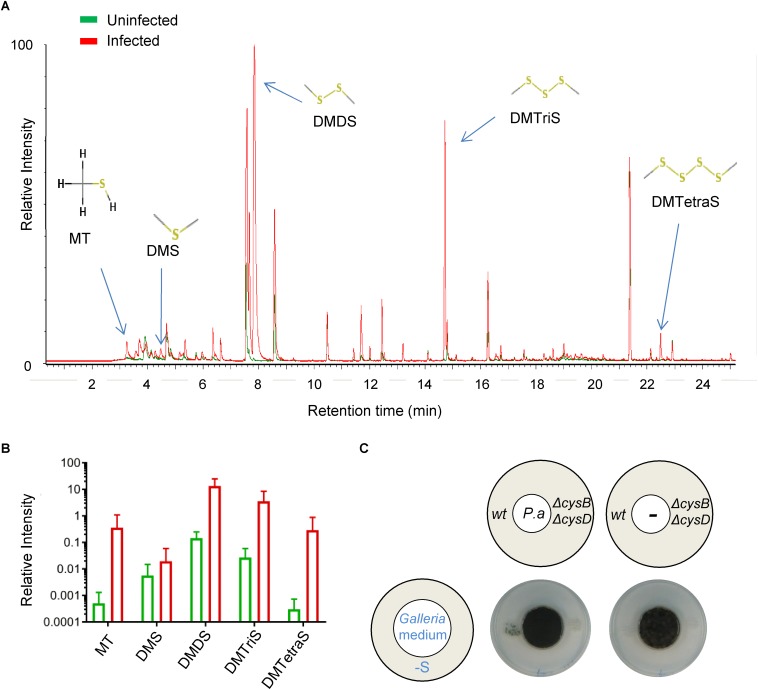
Pseudomonas aeruginosa produces VSCs inside infected Galleria, which are exploited as S-sources by A. fumigatus. Gas emitted from infected or uninfected Galleria accumulated in the headspace of flasks and was sampled 24 h after infection and analyzed by GC-MS. (A) Chromatogram showing an overlay of the peaks for an infected and an uninfected sample. (B) Relative normalized intensity (shown in logarithmic scale) of each of the VSCs peaks detected in two independent experiments with five biological replicates. VSCs accumulated in the flask containing infected Galleria. (C)
P. aeruginosa (P. a) growing on a solid medium prepared from homogenized Galleria triggered distal A. fumigatus growth on sulfur depleted medium. Plates were incubated at 37°C for 3 days.